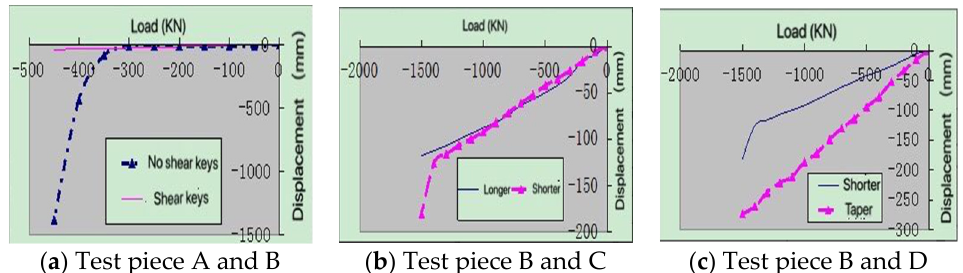
Figure 6. Comparison of load-deformation curves.